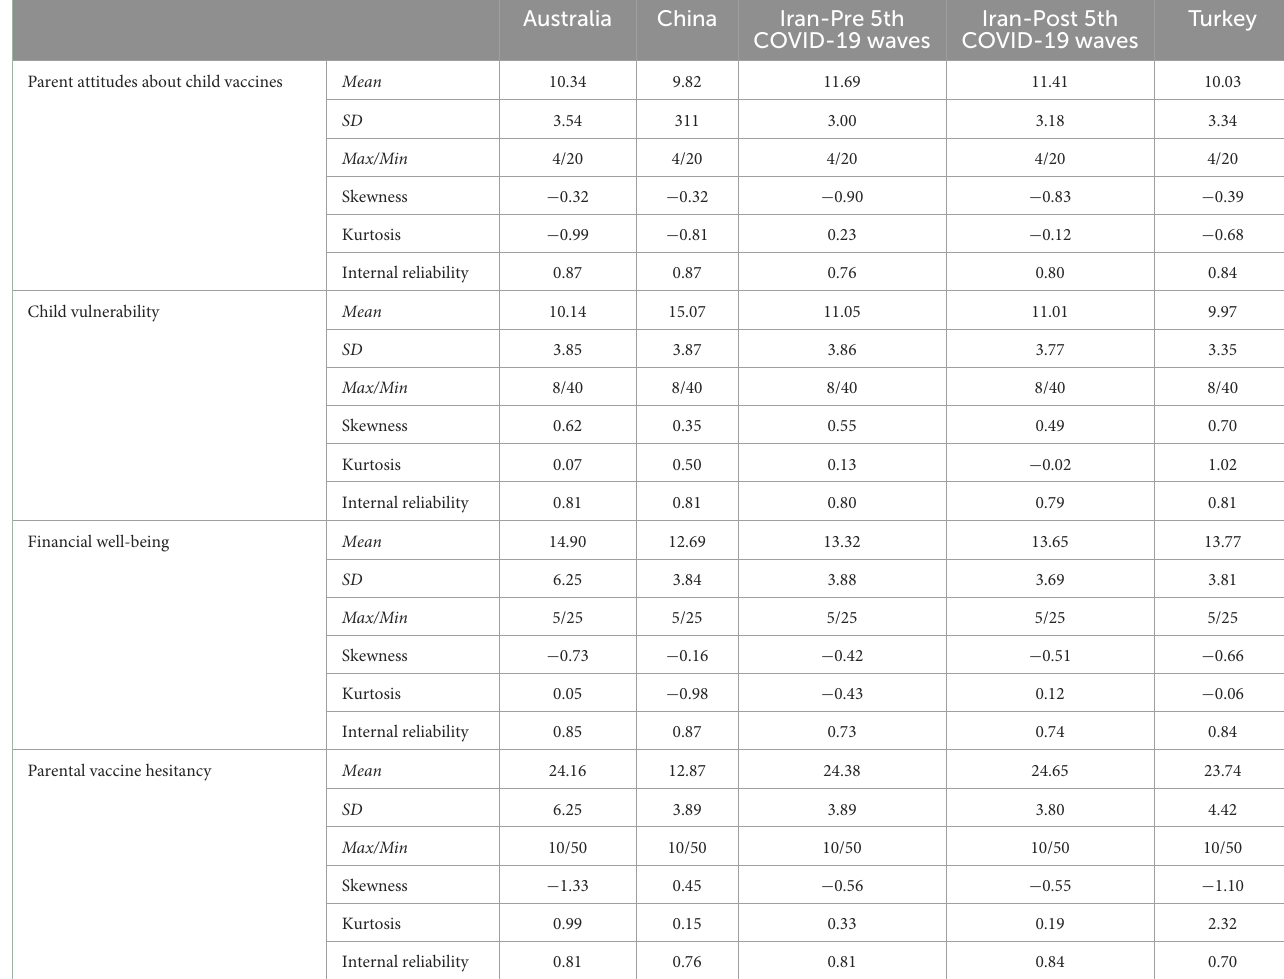
TABLE 2 Observed scale